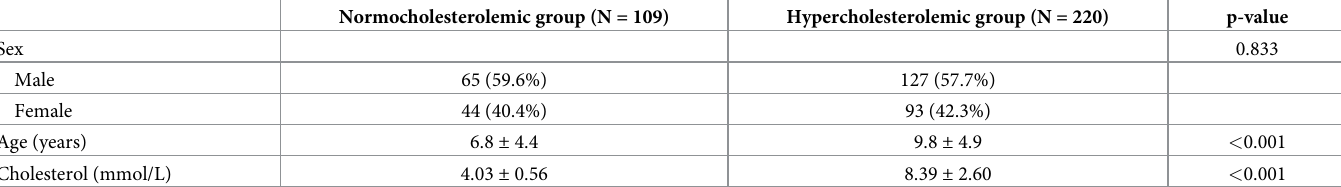
Table 2. Basic characteristics of study